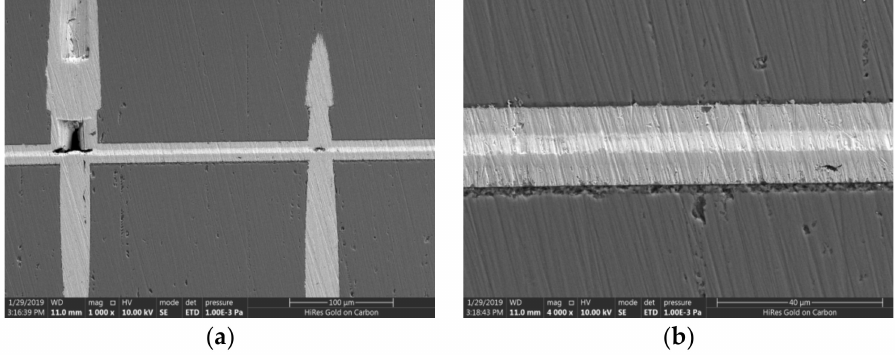
Figure 8. SEM images of the wafer bonding interface. ( a ) 1000 × with TSVs, ( b ) 4000 × without